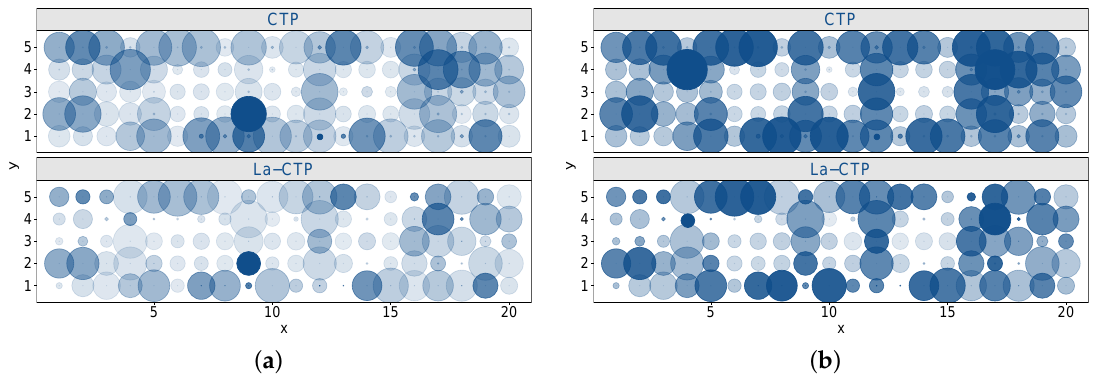
Figure 10. Comparisons in beaconing overhead under two protocols running in EH2. ( a ) beacon sent; ( b ) beacon